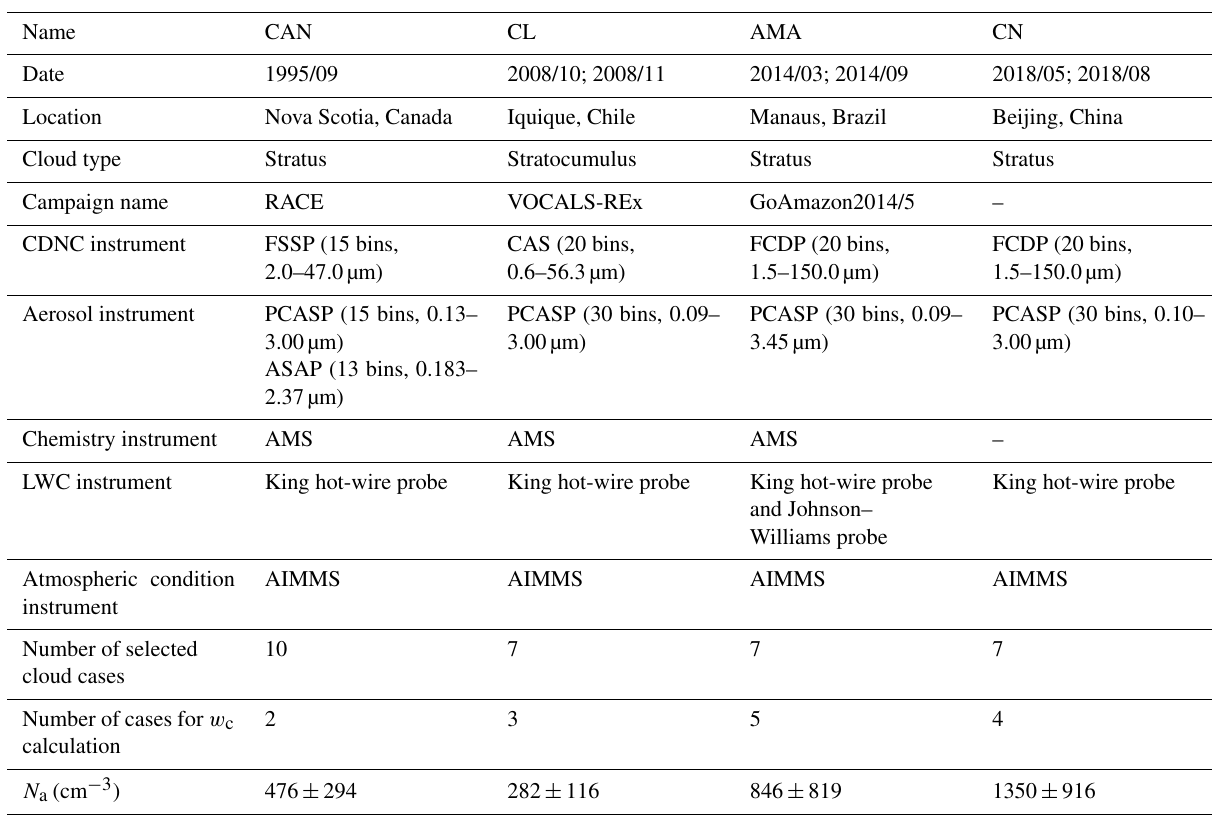
Table 2. An overview of the four aircraft campaigns in this